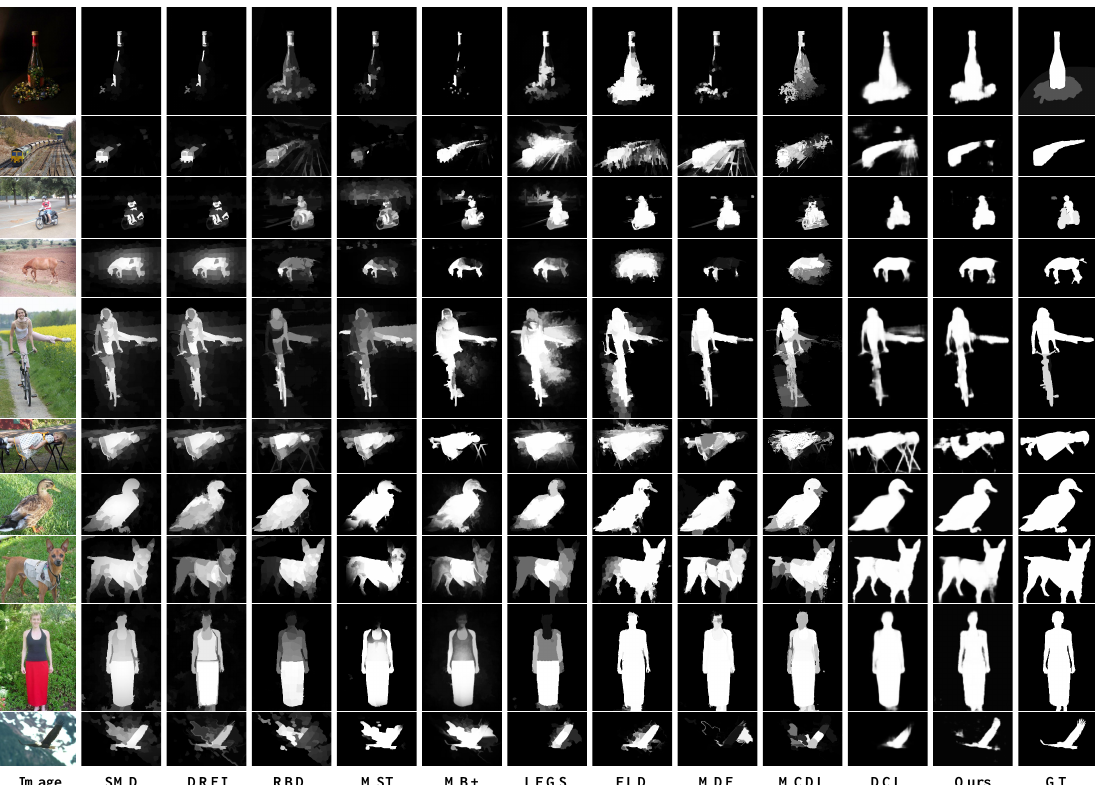
Figure 5. Visual comparison with the state-of-the-art